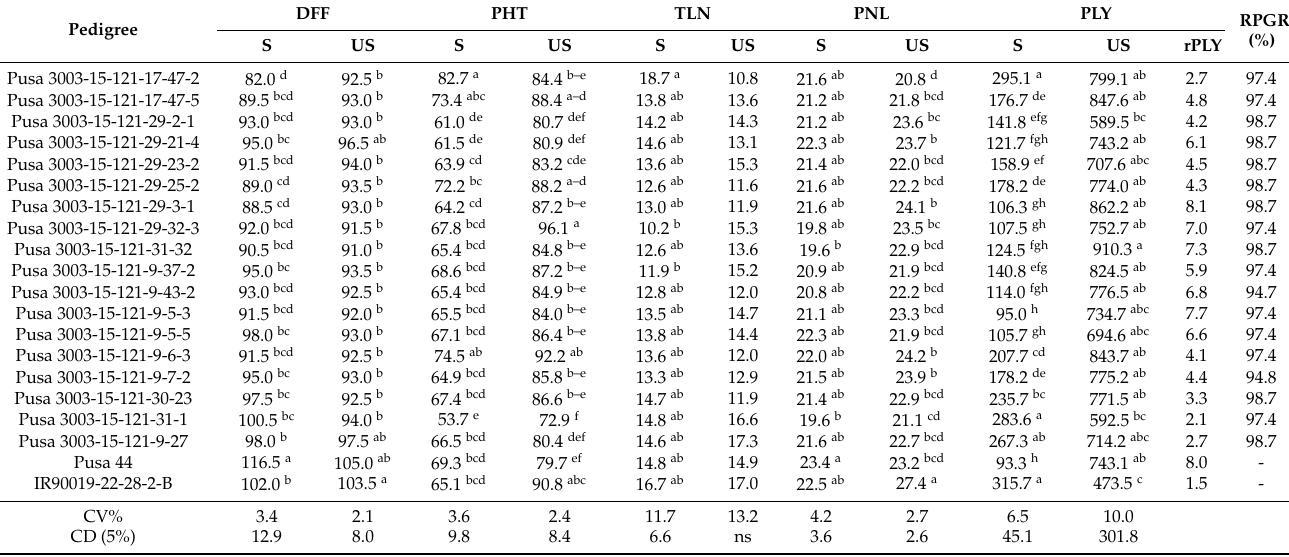
Table 5. Agronomic characteristics of Pusa 44 qDTY12.1 -NILs under stressed and unstressed conditions during Kharif 2019 in New Delhi.